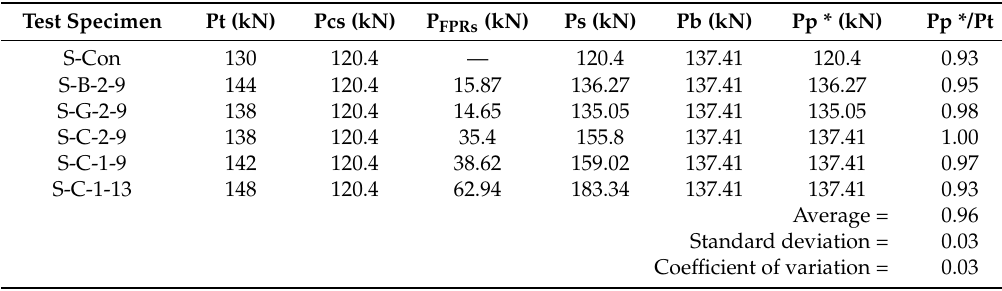
Table 6. Experimental and theoretical prediction loading-carrying